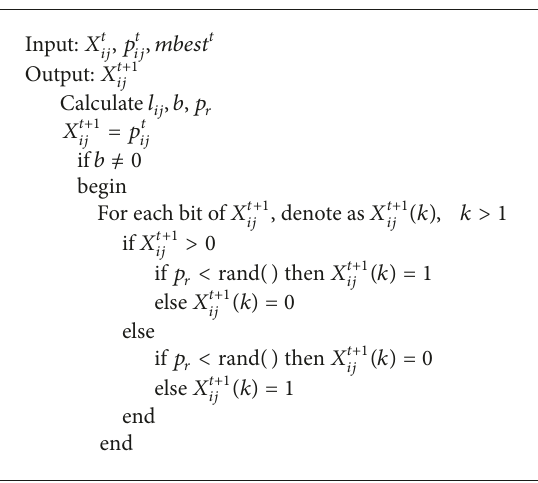
Algorithm 3: Trans 𝑋 : 𝑋 𝑡+1 𝑖𝑗